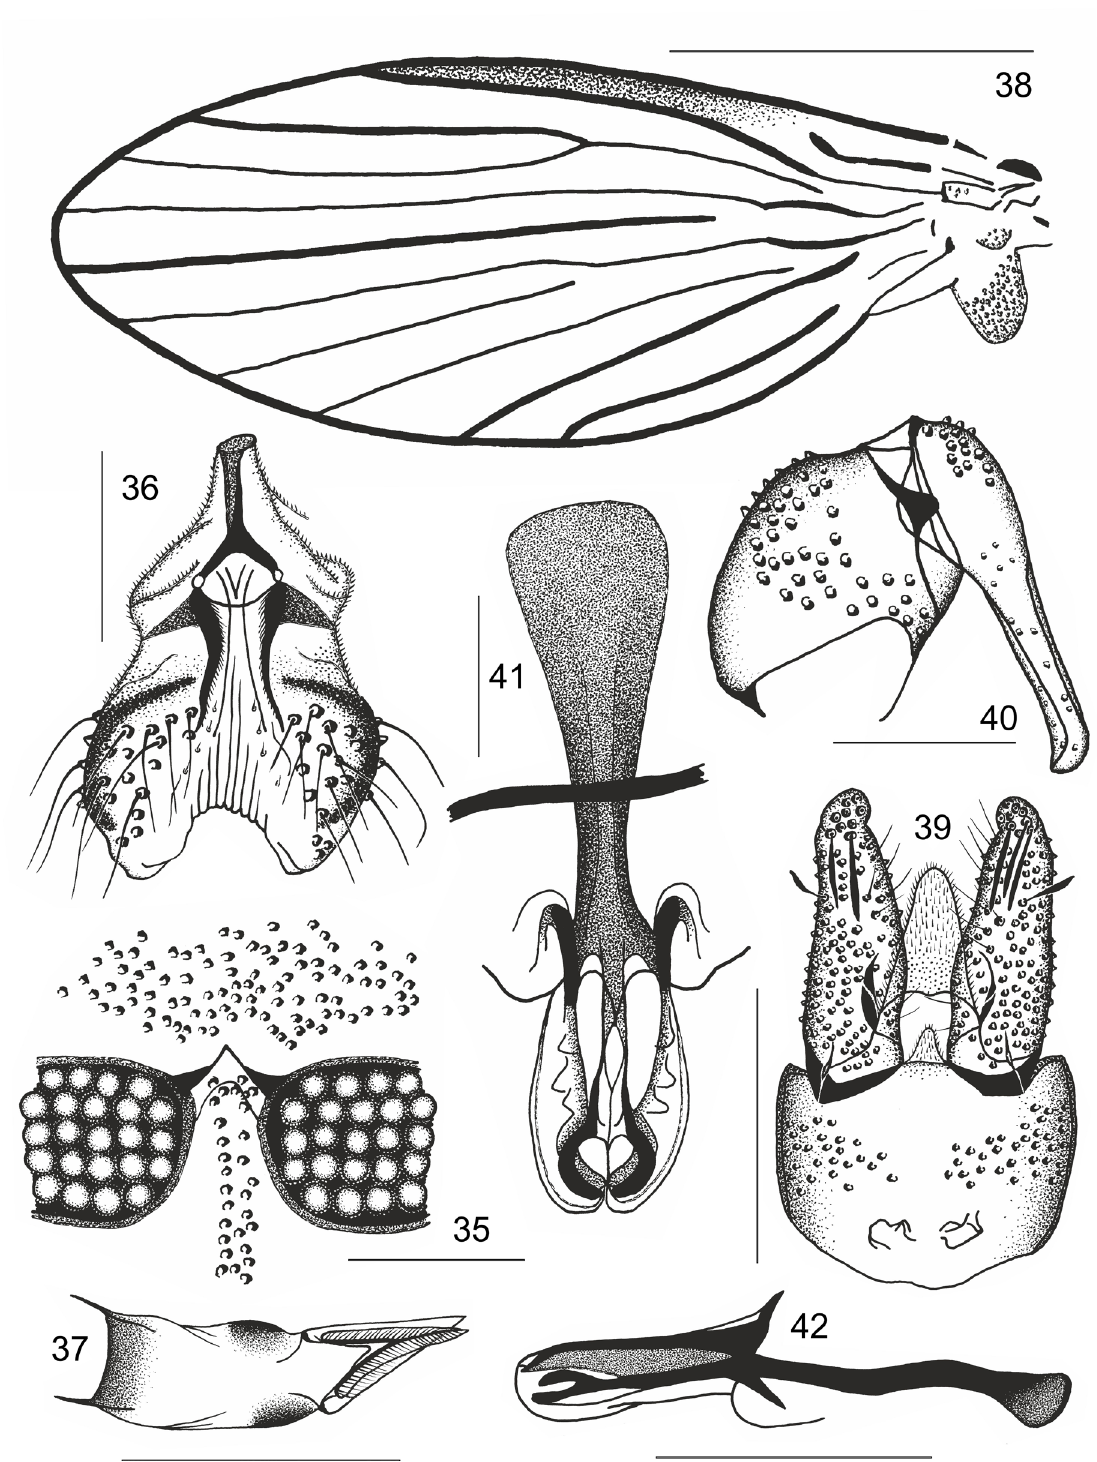
Fig 35–42. Thornburghiella salihi sp. nov., ♂. 35 . Frons and facets in detail. 36 . Terminal lobes of labium, dorsal view. 37 . Cibarium, labrum and epipharynx, dorsal view. 38 . Wing. 39 . Epandrium, epandrial appendages, epiproct and hipoproct, dorsal view. 40 . Gonopod, diagonal view. 41 . Aedeagal complex and hypandrium, dorsal view. 42 . Aedeagal complex in lateral view. Scale bars: 35–36, 40–41 = 0.1 mm; 37, 39, 42 = 0.2 mm; 38 = 1